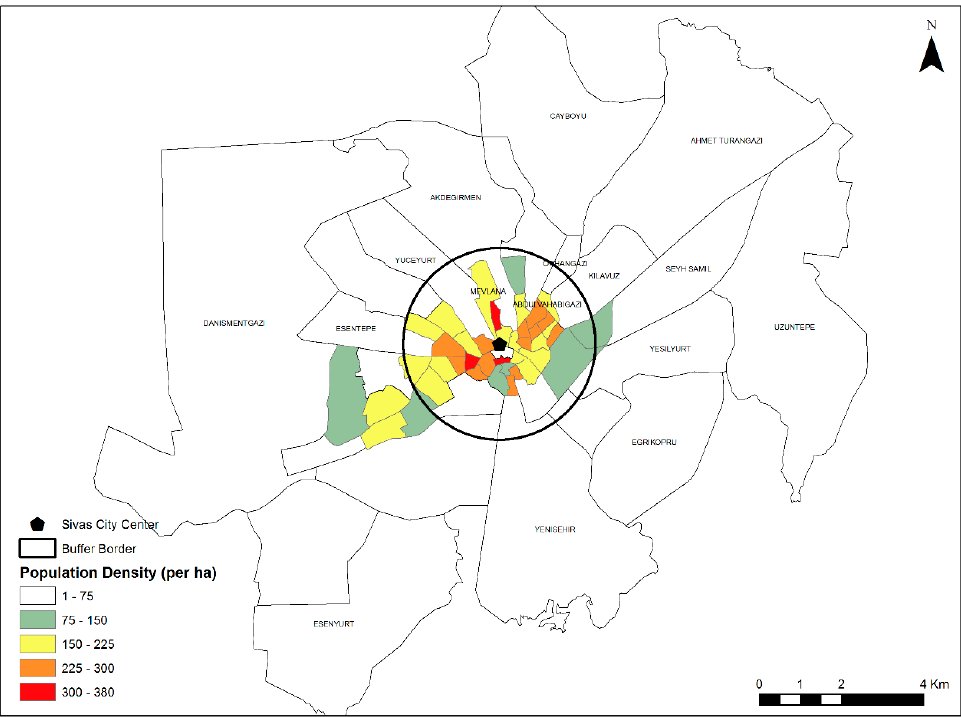
Figure 4. Population density map of Sivas.